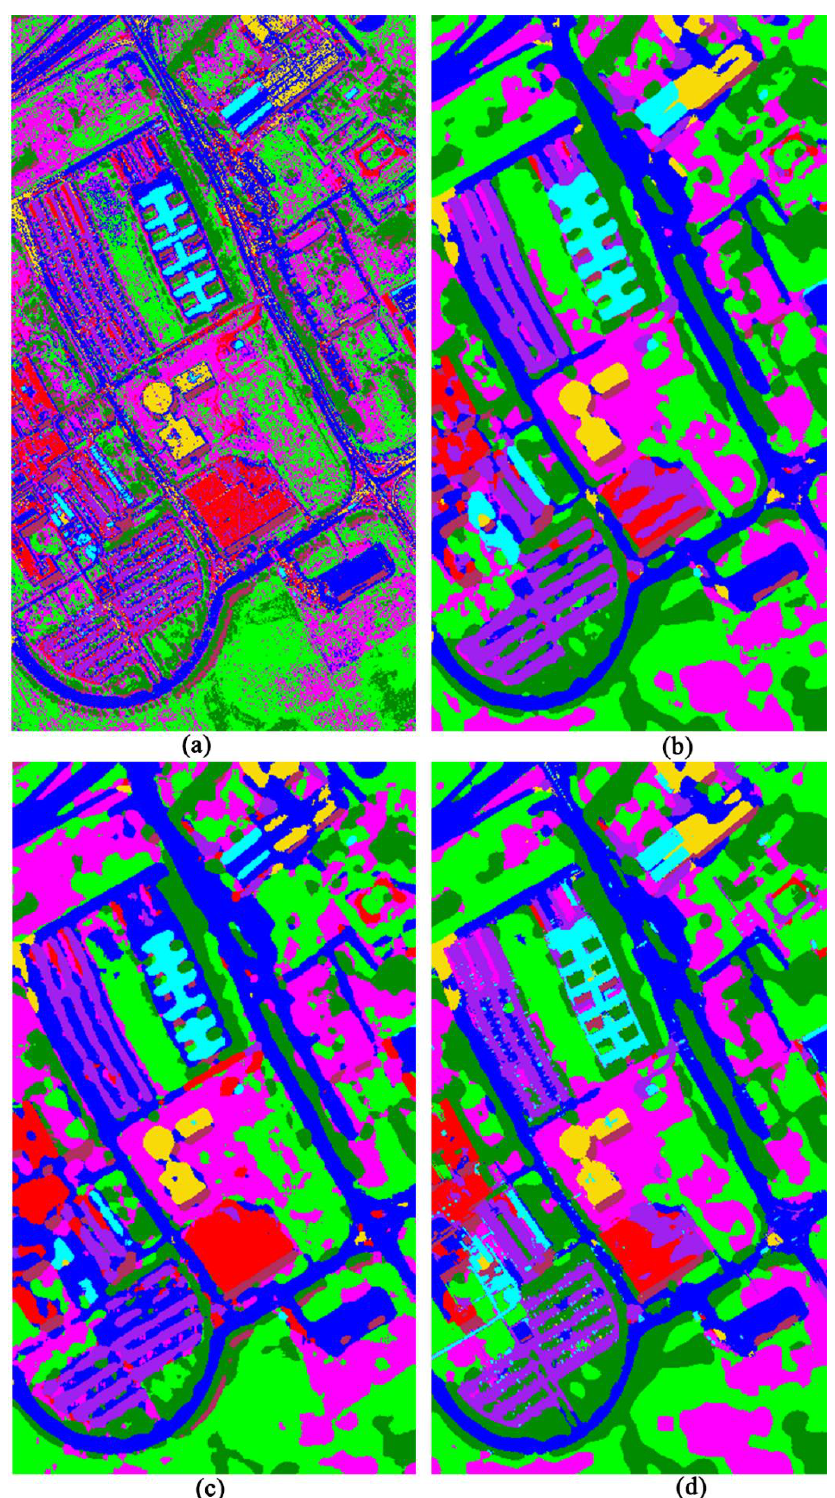
Figure 5. Comparison based on the initial classified maps and different post-classification approaches for the Pavia University image: ( a ) initial classification map based on the MLC classifier, ( b ) post-classification map acquired by GPCF with a 9 × 9 window size, ( c ) post-classification map acquired by majority voting with a 9 × 9 window size, and ( d ) post-classification map acquired by the proposed D-AMVS with 𝑇 1 = 60 and 𝑇 2 = 80 .